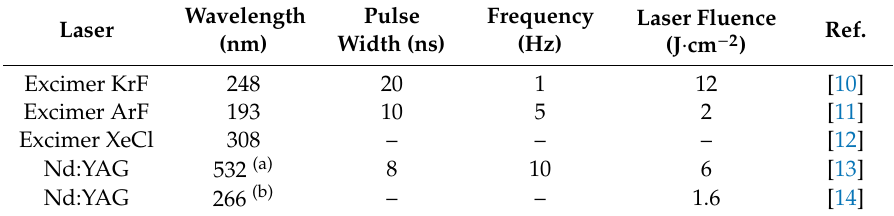
Table 1. Typical laser beams for PLD films of transition-metal (TM) oxides for energy storage. Wavelength Pulse Frequency Laser (nm) Width (ns) (Hz)